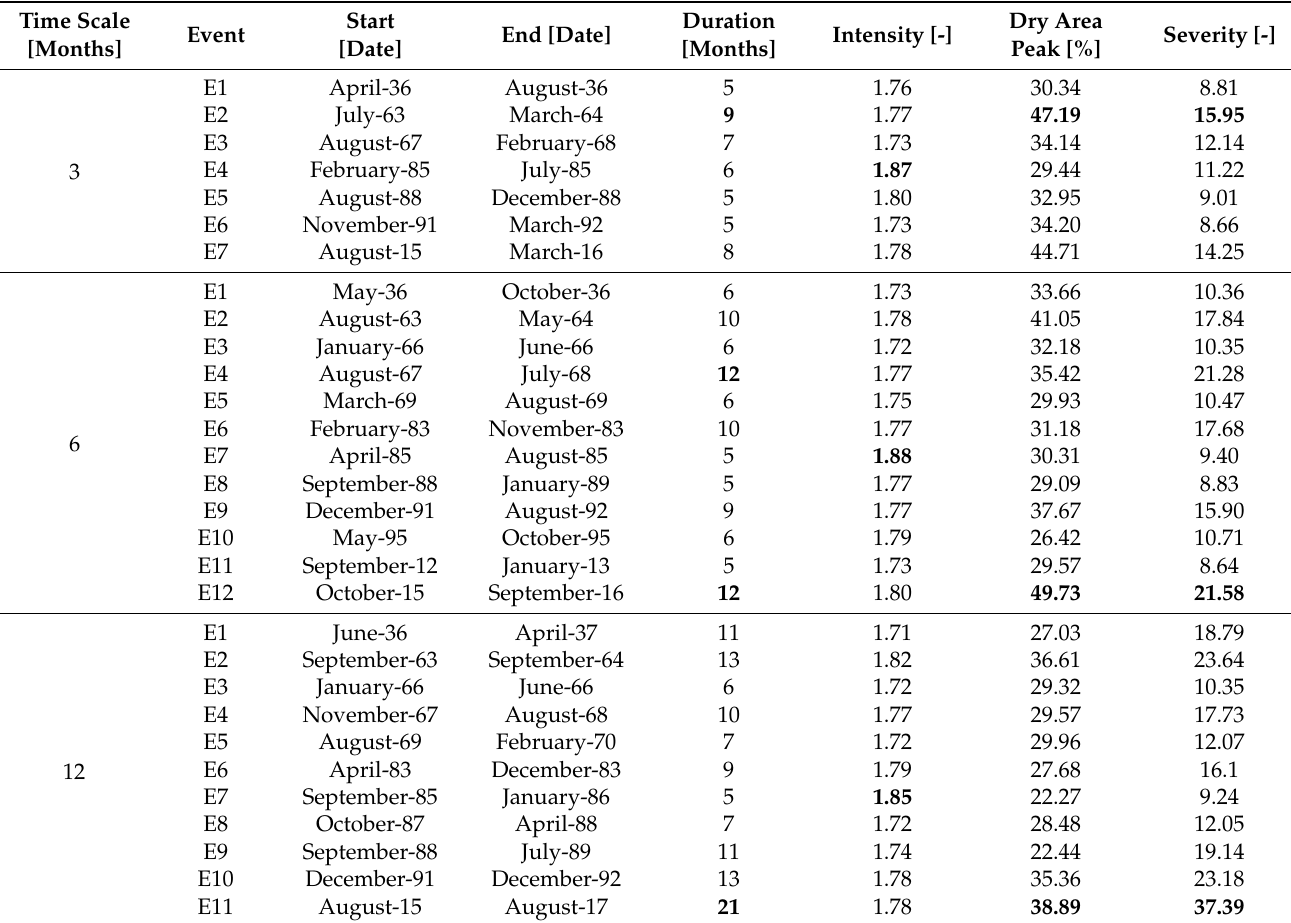
Table 2. Main features of the extreme drought events 1 identified over the ARB during